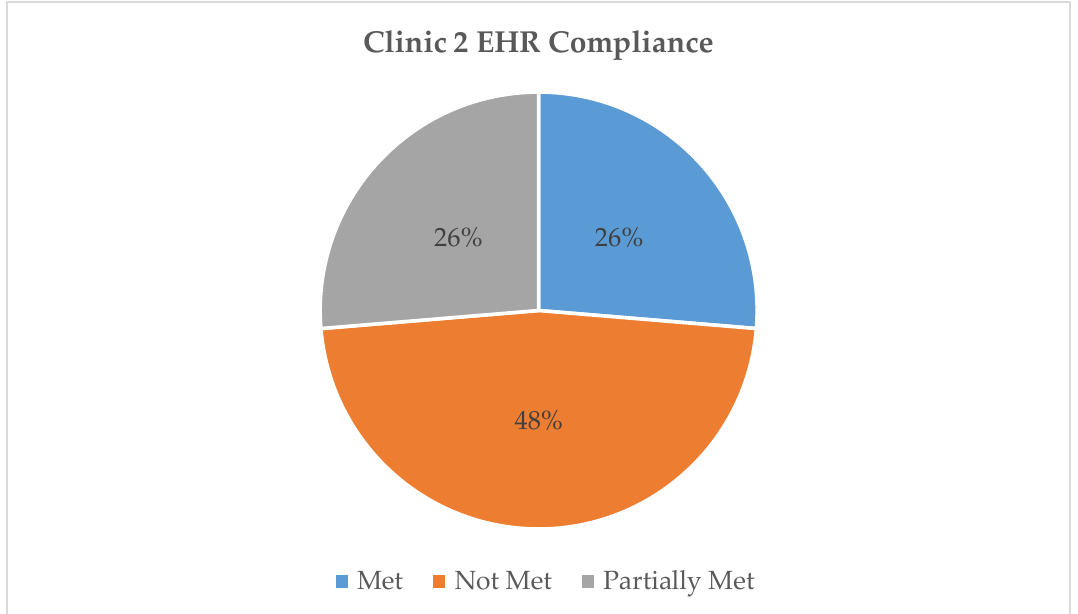
Figure 3. Clinic 2 EHR compliance with AAP recommendations.